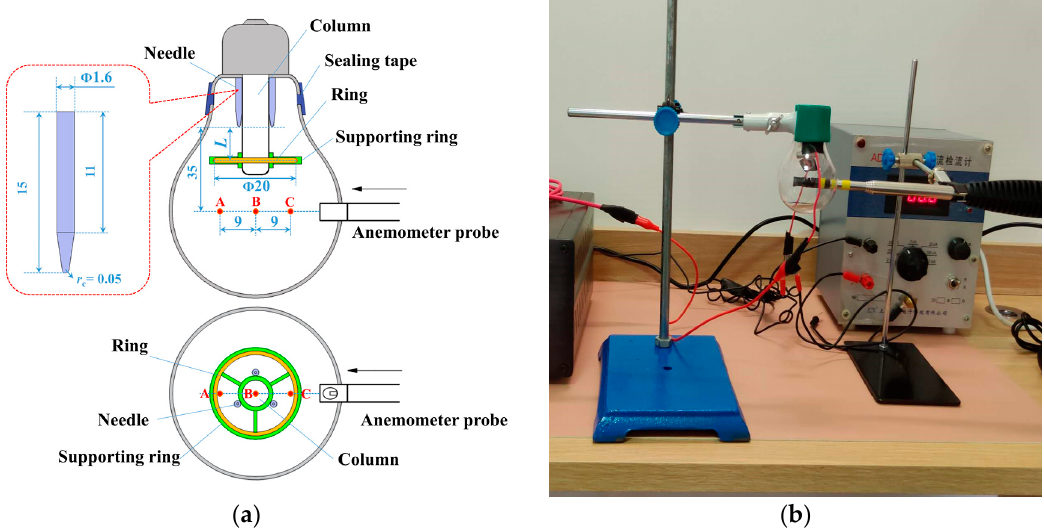
Figure 1. Schematic diagram of ionic wind velocity test: ( a ) structure of LED bulb with ionic wind device. A: the farthest spot from the entrance hole for anemometer probe, B: the middle spot from the entrance hole for anemometer probe, C: the nearest spot from the entrance hole for anemometer probe; and, ( b ) photograph of experimental setup for measuring ionic wind velocity.